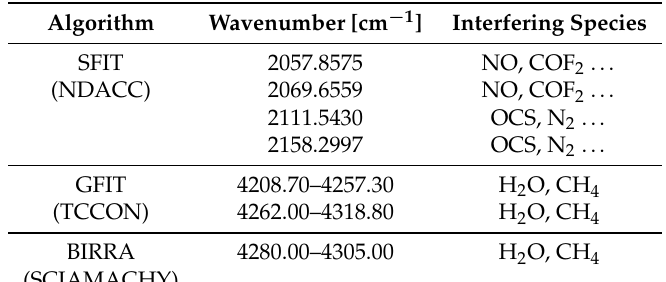
Table 2. Center wavelengths (for the NDACC) and spectral windows (for the TCCON and Beer InfraRed Retrieval Algorithm, BIRRA) used for the retrieval of CO. The NDACC relies on narrow spectral fitting regions [27], while the retrieval strategy of the TCCON prefers much wider spectral regions [28]. The BIRRA uses one spectral fitting window in Channel 8. The NDACC uses the Scale Invariant Feature Transform (SFIT) algorithm, and the TCCON applies GFIT to acquire the GGG2014 data